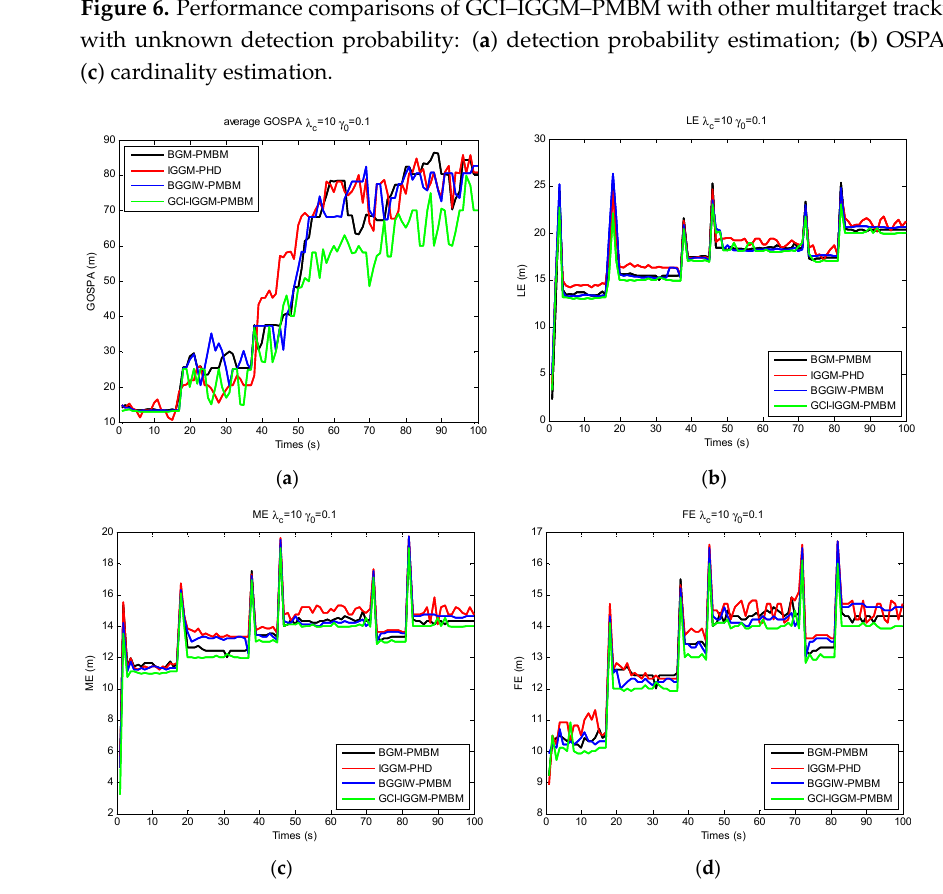
Figure 7. Performance comparisons of GCI–IGGM–PMBM with other multitarget tracking schemes with unknown detection probability: ( a ) GOSPA; ( b ) LE; ( c ) ME; ( d ) FE.